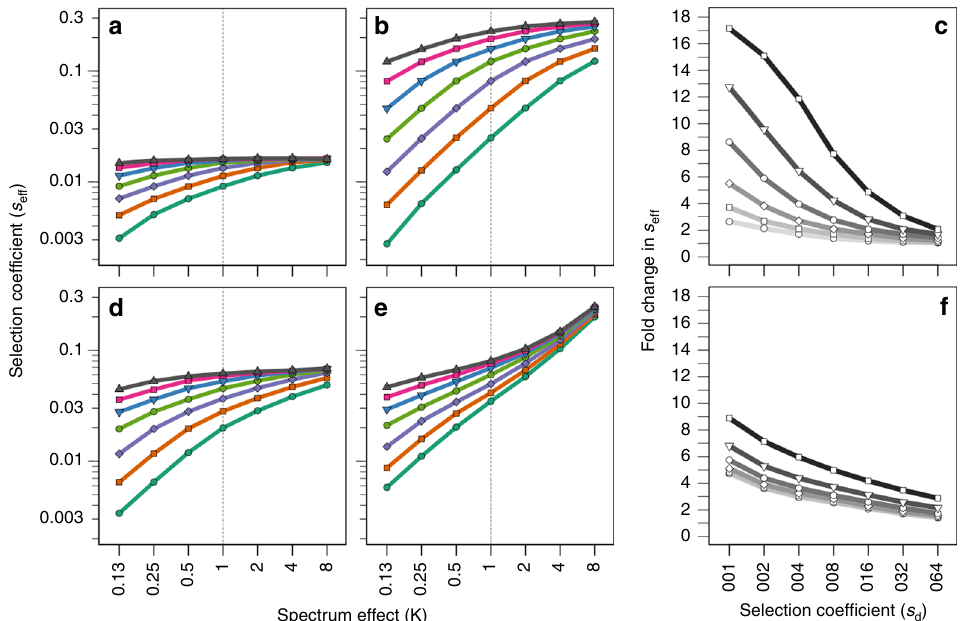
Fig. 3 Impact of the deleterious and lethal mutation rate on antimutator dynamics. Panels a and b show antimutator fi tness under two extreme values of the basal deleterious mutation rate ( u d = 0.5 × 10 − 4 and u d = 8 × 10 − 4 , respectively). Points and colours follow the same convention as in Fig. 2. Panel c shows the change in the antimutator ’ s effective selection coef fi cient ( s eff ) for various values of the basal deleterious mutation rate (from top to bottom, u d equals: 1.6 × 10 − 3 , 8 × 10 − 4 , 4 × 10 − 4 , 2 × 10 − 4 , 1 × 10 − 4 , 0.5 × 10 − 4 ). Fold change refers to the change in s eff from κ = 0.25 to κ = 4. Panels d and e show the effects on antimutator dynamics of spectrum-driven differences in the propensity to produce lethal mutations, under two extreme values of the basal lethal mutation rate ( u l = 0.2 × 10 − 5 and u l = 6.4 × 10 − 5 , respectively). Points and colours as in Fig. 2. Panel f shows the change in s eff for various values of the basal lethal mutation rate (from top to bottom, u l equals: 6.4 × 10 − 5 , 3.2 × 10 − 5 , 1.6 × 10 − 5 , 0.8 × 10 − 5 , 0.4 × 10 − 5 , 0.2 × 10 − 5 ). Fold change is de fi ned as in c . In all cases, the mutation rate of the resident mutator was fi xed to a single value (m = 300 ) . Other parameters as described in